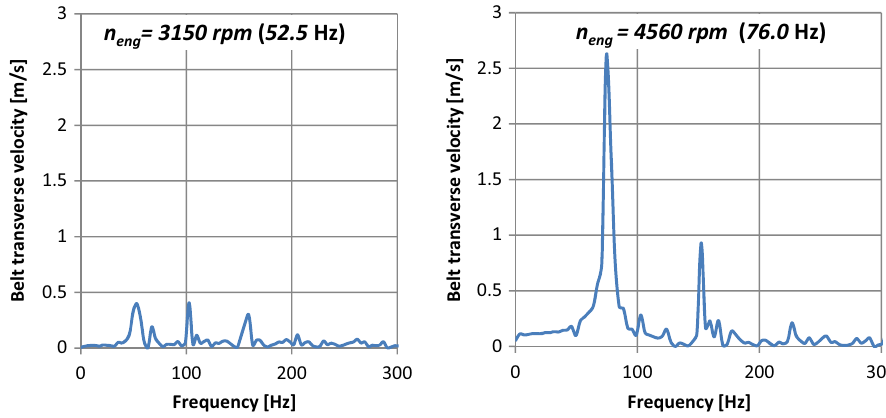
Figure 6: Transverse velocity frequency spectrum ( velocity measured 70 mm from left belt - pulley contact point at tight part of belt ) for selected engine rotational speeds ( 3,150 and 4,560 rpm ) , constant transmission ratio ( 0.9 ) , and full throttle